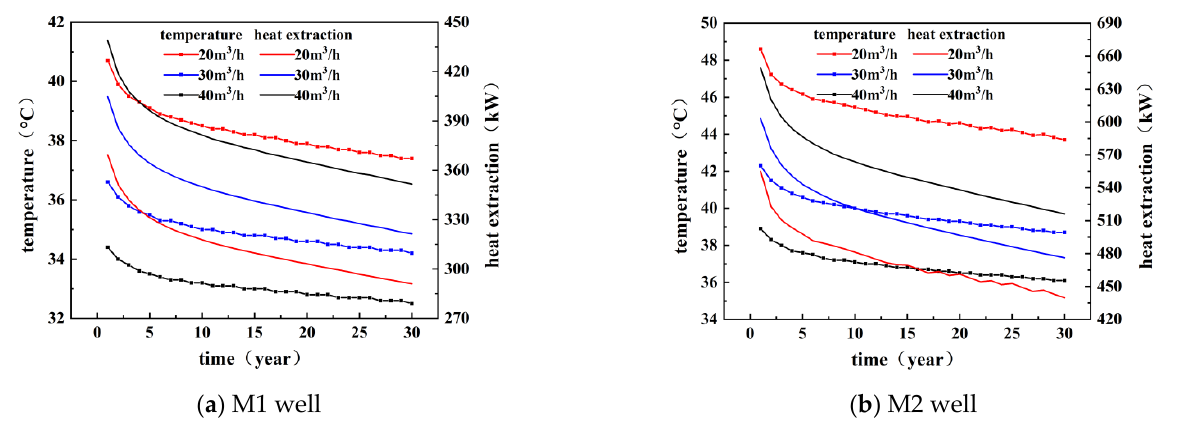
Figure 7. Comparison of production temperature and heat extraction at different injection flows.